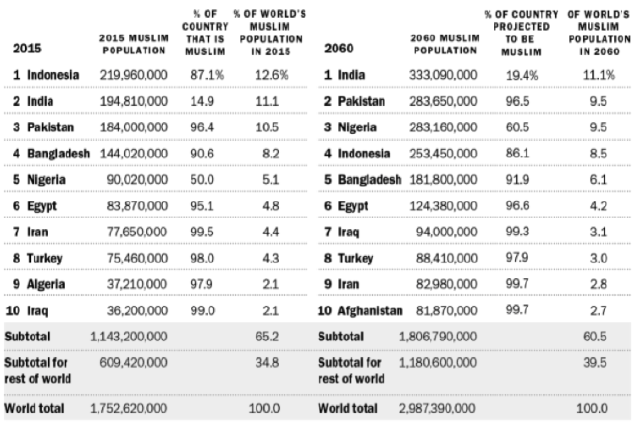
Table 2: 10 Countries with The Largest Muslim Populations, 2015 and 2060